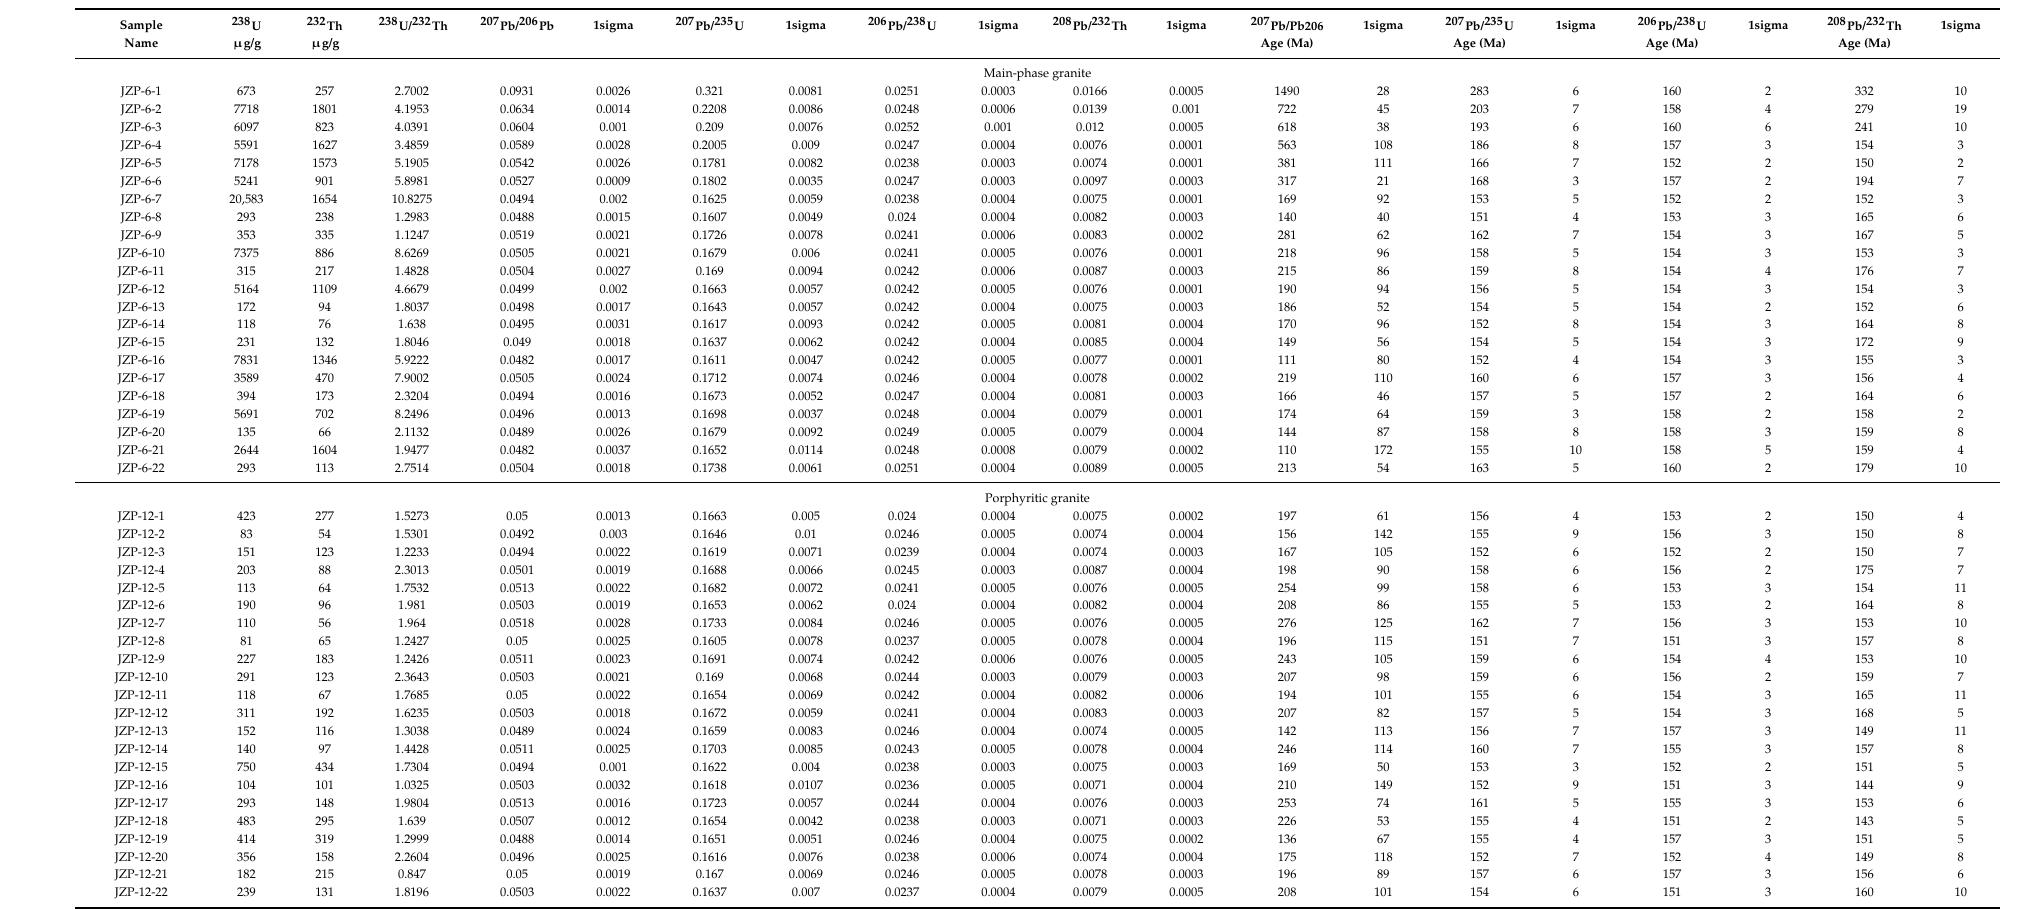
Table 2. LA-ICP-MS zircon U–Pb dating results of the Jinzhuping